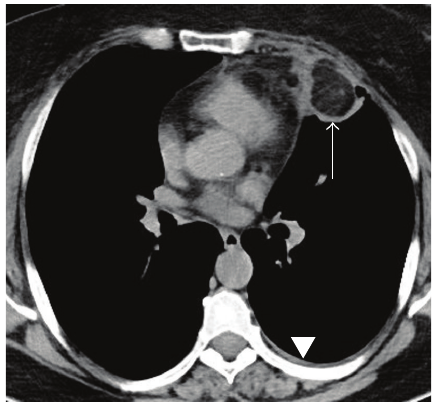
Figure 4: CT scan after 3 months showing a significant reduction in the size of the mass